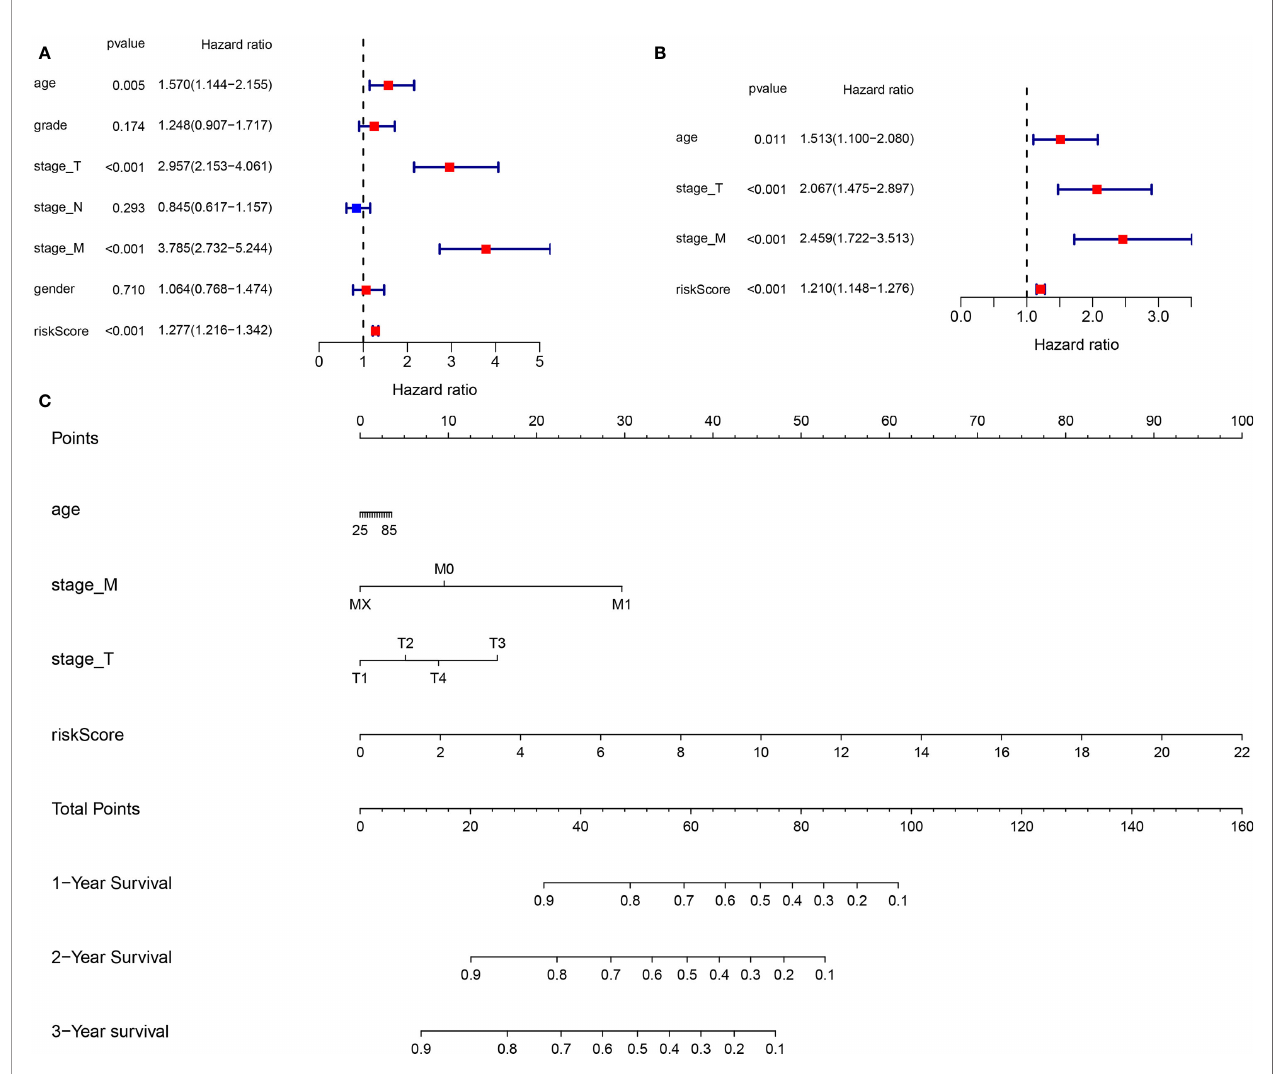
FIGURE 8 | Construction of a new prognostic nomogram. (A) Univariate Cox regression analyses (B) Multivariate Cox regression analyses (C) Nomogram analyses of the selected prognostic